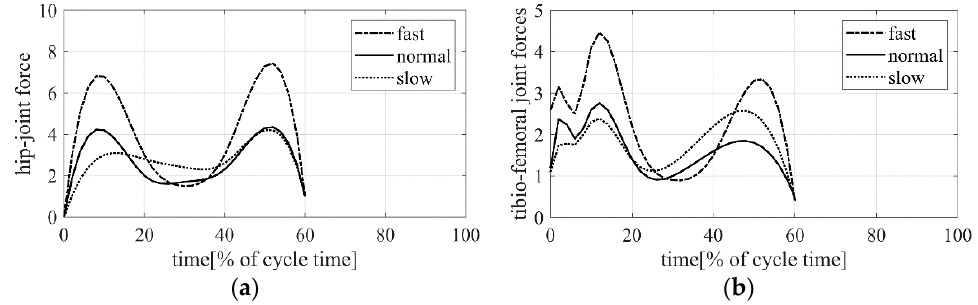
Figure 10. The magnitude of the results during walking at slow, normal and fast speeds (0–20% of cycle time: heel strike, 40–60% of cycle time: toe off, 80–100% of cycle time: other heel strike) [32]: ( a ) Average variation during walking cycle of the resulting hip joint force; ( b ) average variation during walking cycle of the force transmitted to the tibio-femoral part of the knee joint.